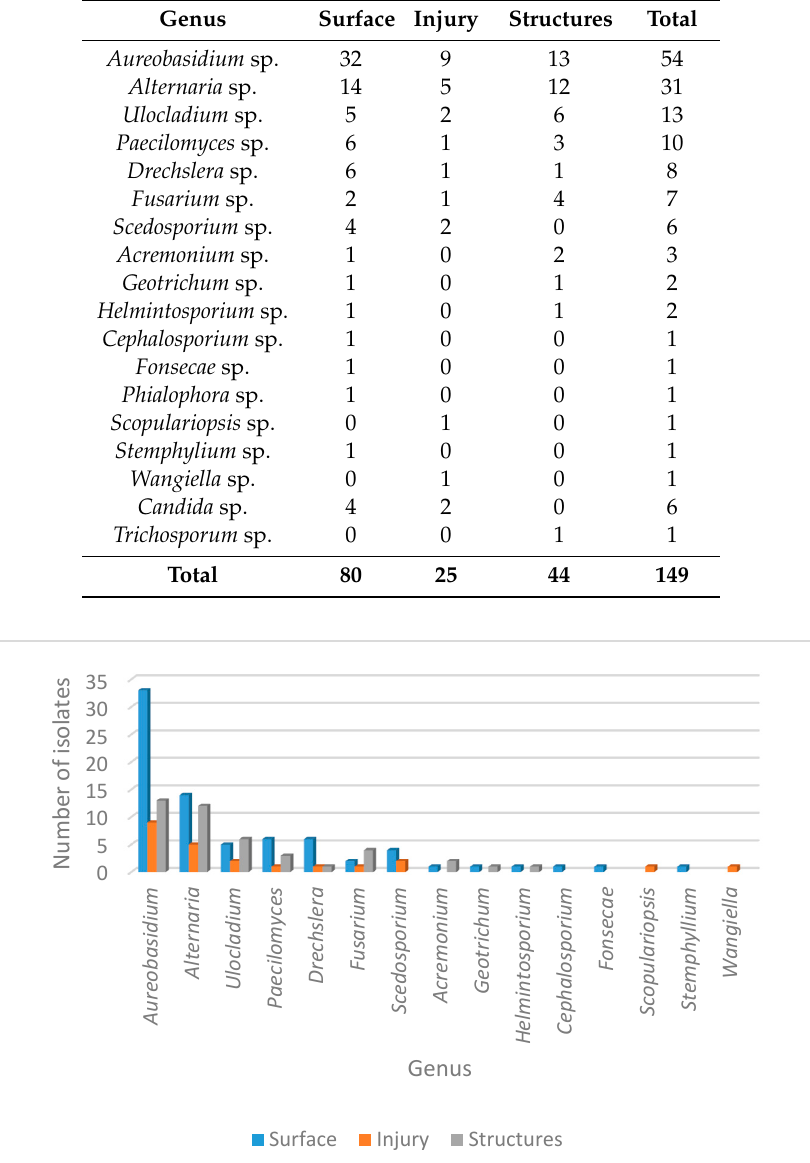
Figure 2. Abundance of fungal genera isolated from leaf disease in Crataegus . The number of fungal isolates corresponding to the different genera identified phenotypically is shown. Isolate distribution is presented for the surface (blue), for injured tissue (orange) and for the structures (gray).